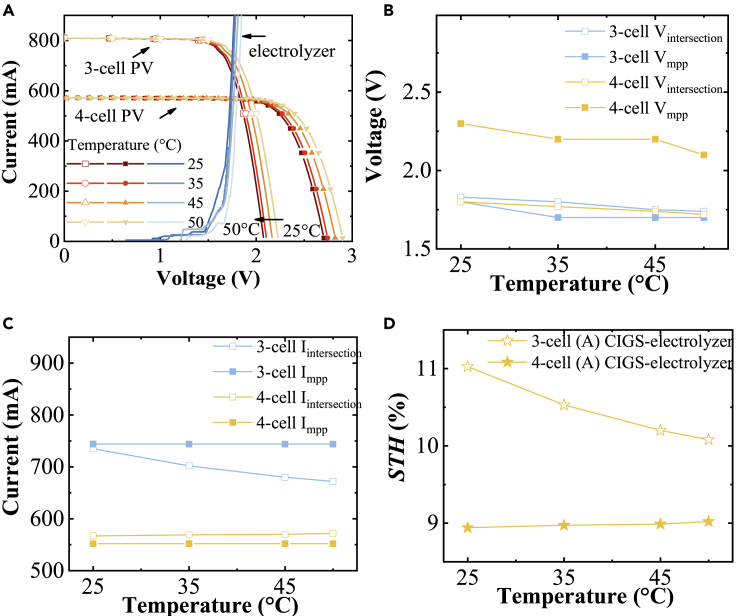
Current-voltage characteristics of the 3-cell (82 cm2 active area) and 4-cell (78 cm2 active area) (A)CIGS Modules and Electrolyzer Having NiMoV (Cathode)-NiO (Anode) (100 cm2 Catalyst Area) at Different Temperatures(A–D) (A) Current versus voltage, (B) voltage at maximum-power-point of the PV module curve (Vmmp) and voltage at the intersection of the current-voltage curves of the PV module and the electrolyzer (Vintersection), (C) Immp and Iintersection, and (D) solar-to-hydrogen (STH) efficiency of the (A)CIGS PV-NiMoV-NiO electrolyzer calculated from the current at the intersection.